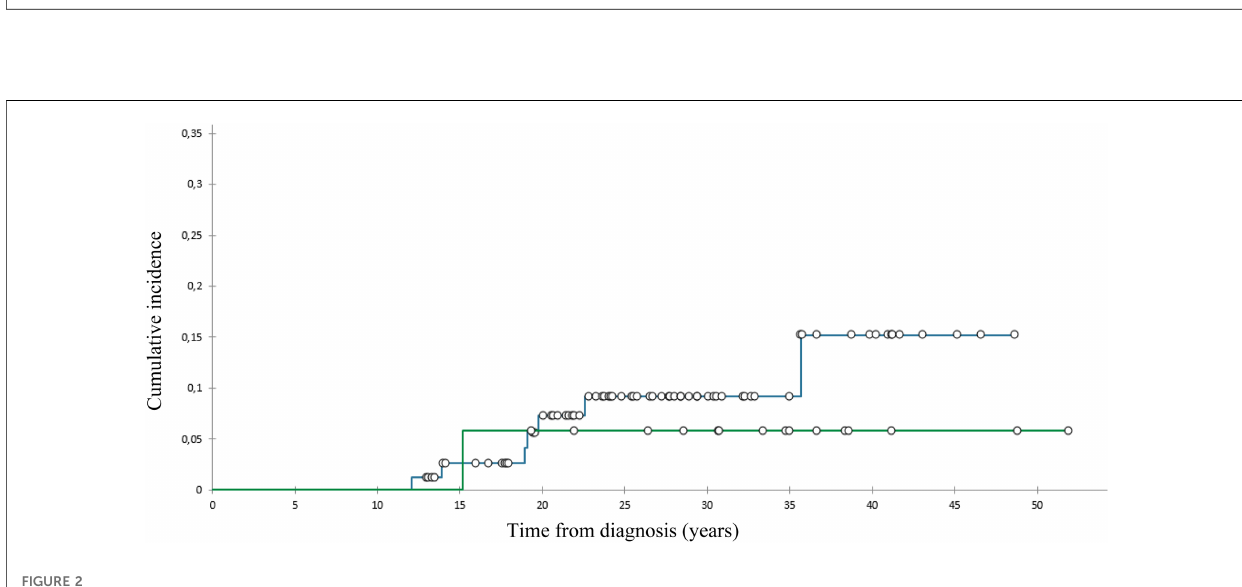
FIGURE 2 Cumulative incidence of subsequent breast cancer, patients with ( ) and without ( ) chest